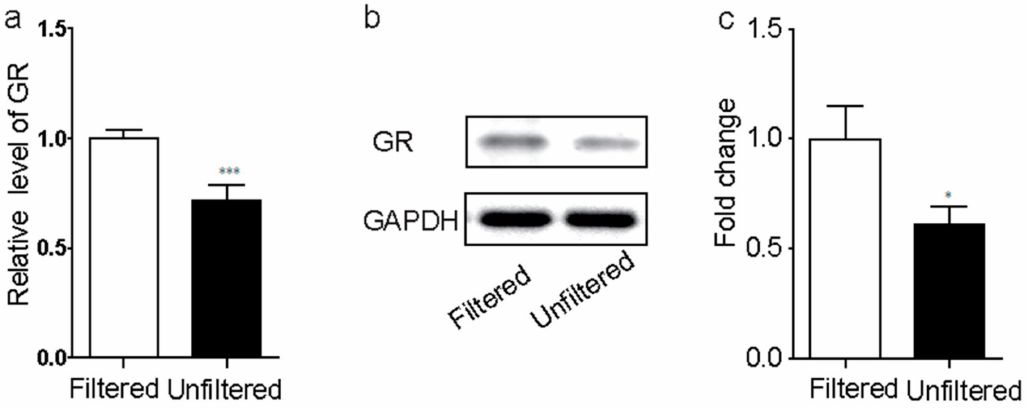
Figure 4. PM 2.5 exposure inhibited hippocampal glucocorticoid receptors (GR) activation in mice. The GR expression level was decreased after PM 2.5 exposure in both genes (( a ), p < 0.001, t16 = 4.587) and protein (( b , c ), p < 0.05, t14 = 2.269) level. * p < 0.05; *** p <